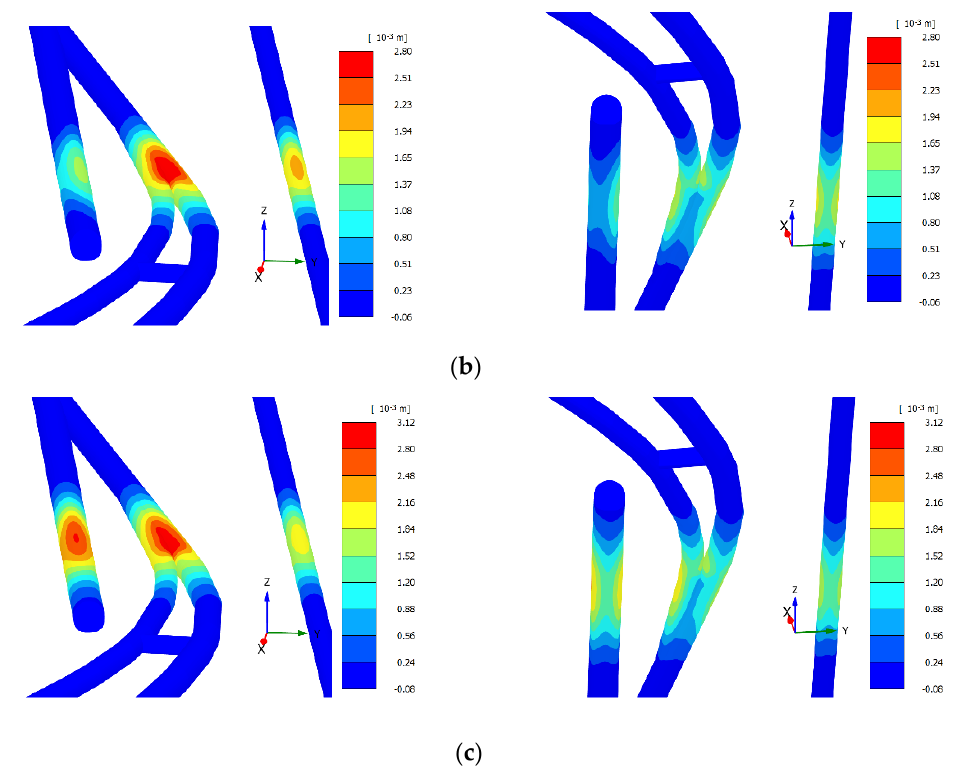
Figure 12. Nephogram of vertical displacement of tunnels: ( a ) stage 3, ( b ) stage 4, ( c ) stage 5.